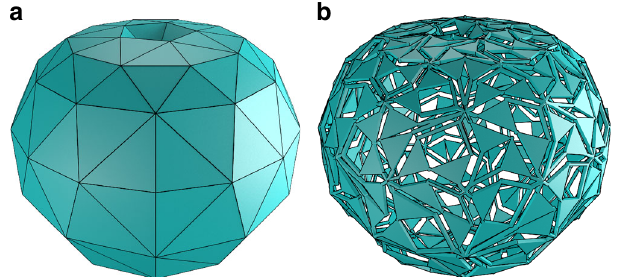
Fig. 9 Dilation of a cardioid. The surface of the cardioid is fi rst triangulated ( a ), after which each triangular face is replaced by a skew pantograph ( b ) to obtain a dilational surface. A movie of the fi nal mechanism is included in the supplementary